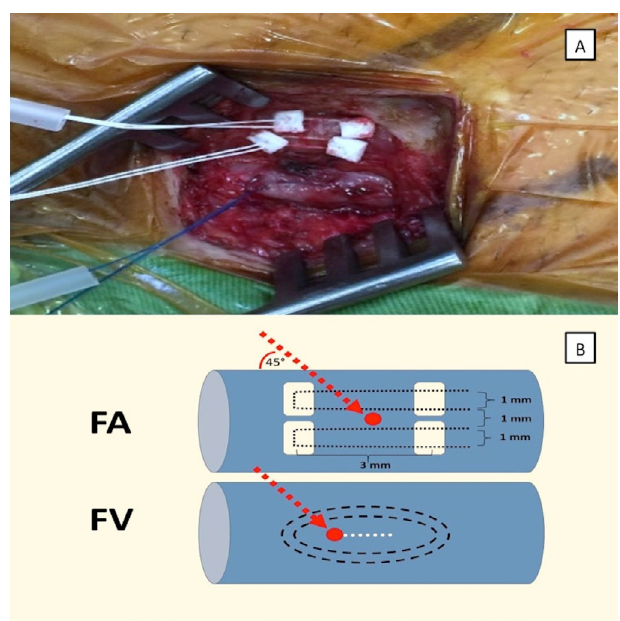
Fig. 1 - A) Placement of double pledgeted polytetrafluoroethylene sutures in the femoral artery and Prolene sutures in the common femoral vein. B) Double-pledgeted sutures are placed horizontally through the adventitial layer of the femoral artery (FA). The red dot shows the puncture site between the two-layered horizontal sutures. Note the lengths and distances between the sutures. Double purse- string sutures were placed in the anterior surface of the common femoral vein (FV). The red dot shows the puncture site and the dotted white line shows the 3 mm incision made before insertion of the venous